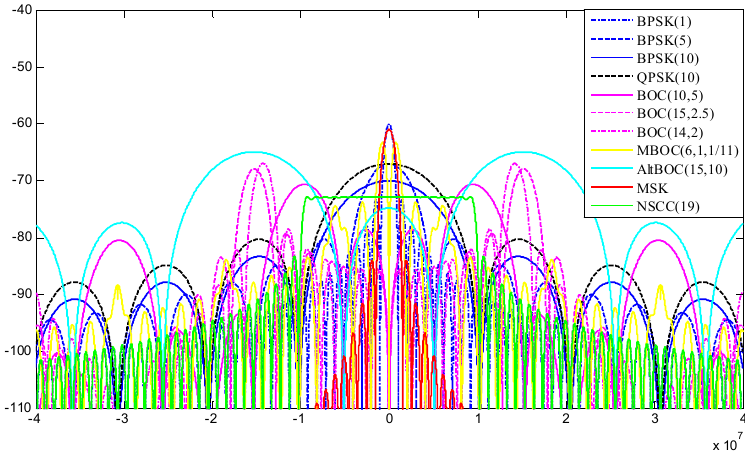
Figure 2. Comparison of PSDs for NSCC and legacy navigation signal modulations.